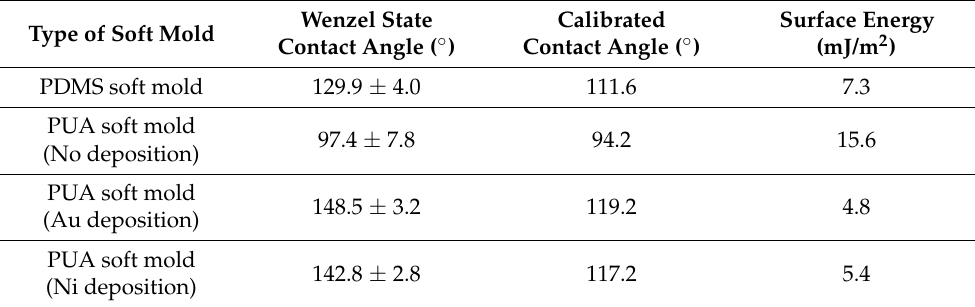
Table 1. Calibrated contact angle of DI water and surface energy on various soft